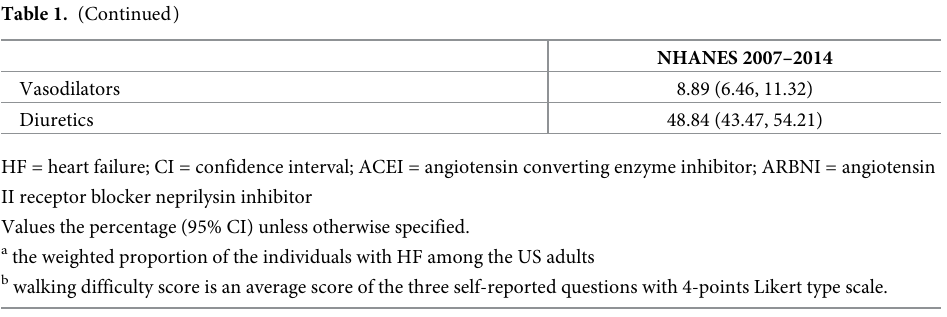
level, patients with SB � 8 hours/day had a greater risk of mortality (HR = 1.51; 95% CI = 1.01, 2.25) when compared to those with SB < 8 hours/day in No-MVPA group only and there was no statistically significant difference in the relative risk of mortality by SB levels among those in the I- and S-MVPA groups ( Online Table 6 in S1 File ). The interaction effect between MVPA and SB was not statistically significant (Wald x 2 = 0.68; df = 2; P = .711).